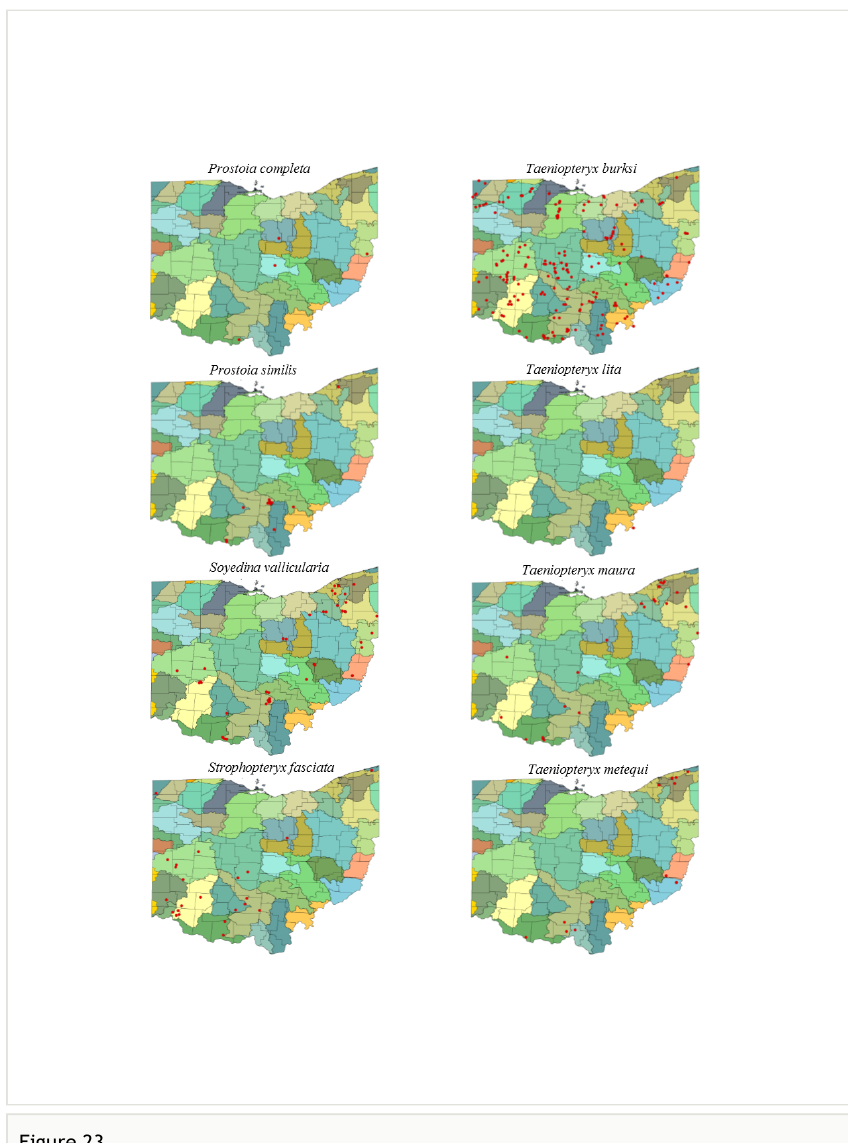
Figure 23. Distribution of Nemouridae and Taeniopterygidae in